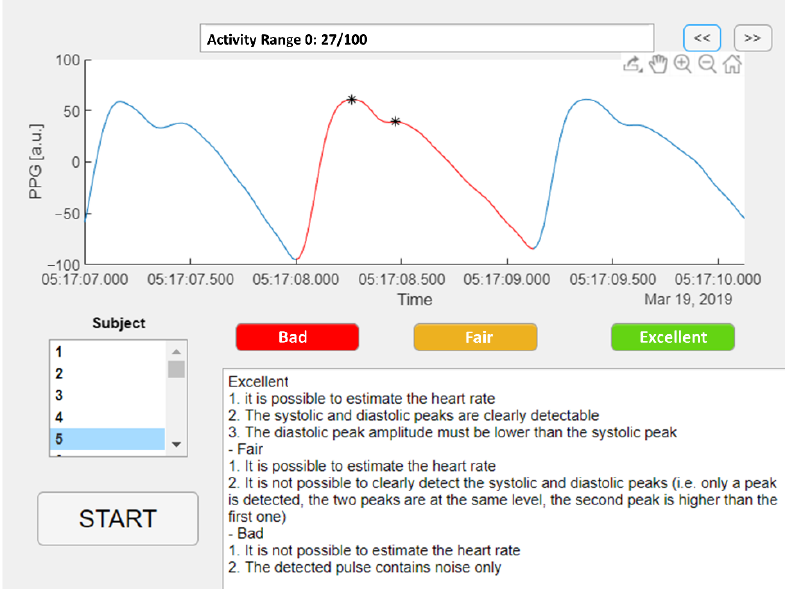
Figure 3. Matlab graphic user interface for PPG pulses annotation.